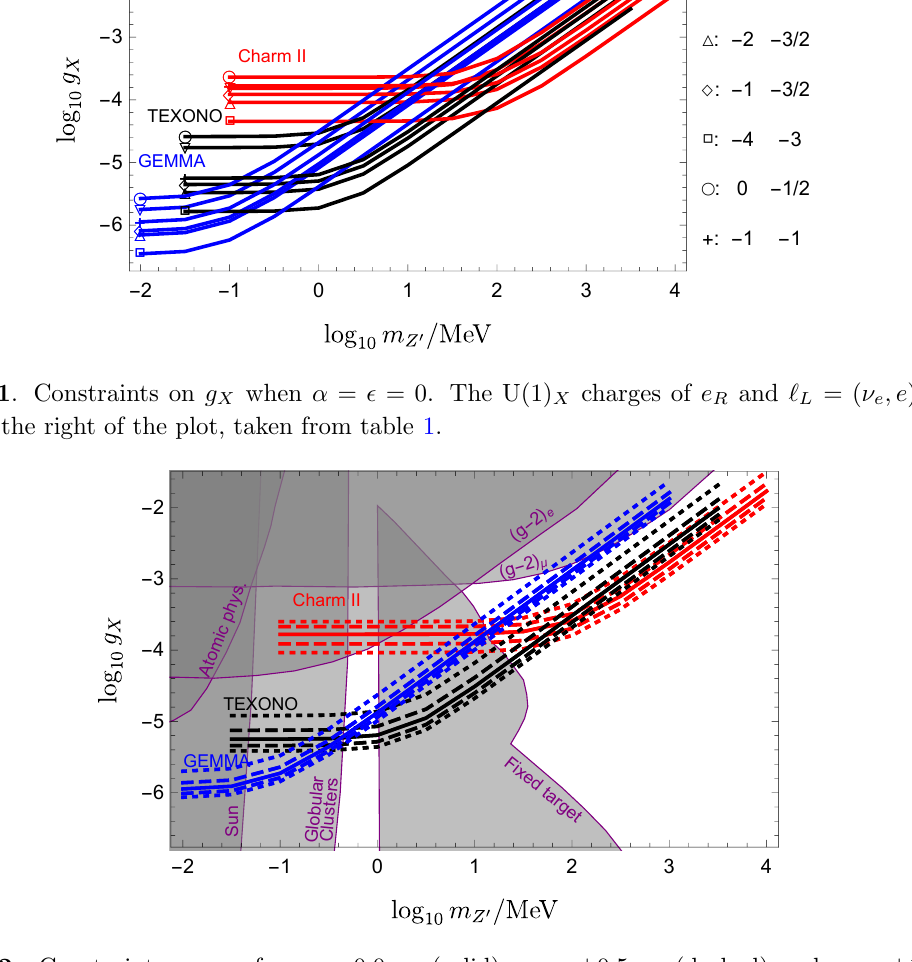
Figure 2 . Constraints on g X for (cid:11) = 0 : 0 g X (solid), (cid:11) = (cid:6) 0 : 5 g X (dashed) and (cid:11) = (cid:6) 1 : 0 g X (dotted), assuming U(1) B (cid:0) L charges and (cid:15) = 0. The bounds with negative (cid:11) are lower than those with positive (cid:11) . The other existing constraints (purple curves) are taken from ref.